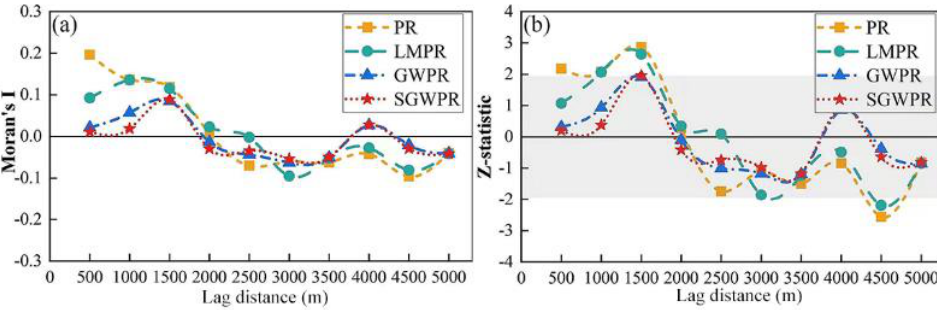
Figure 4. ( a ) Moran’s I and ( b ) Z statistic of the residual analysed at different lag distances. Note: PR represents the Poisson regression, LMPR represents the Liner mixed PR, GWPR represents the Geographically weighted PR, SGWPR represents the semiparametric GWPR.